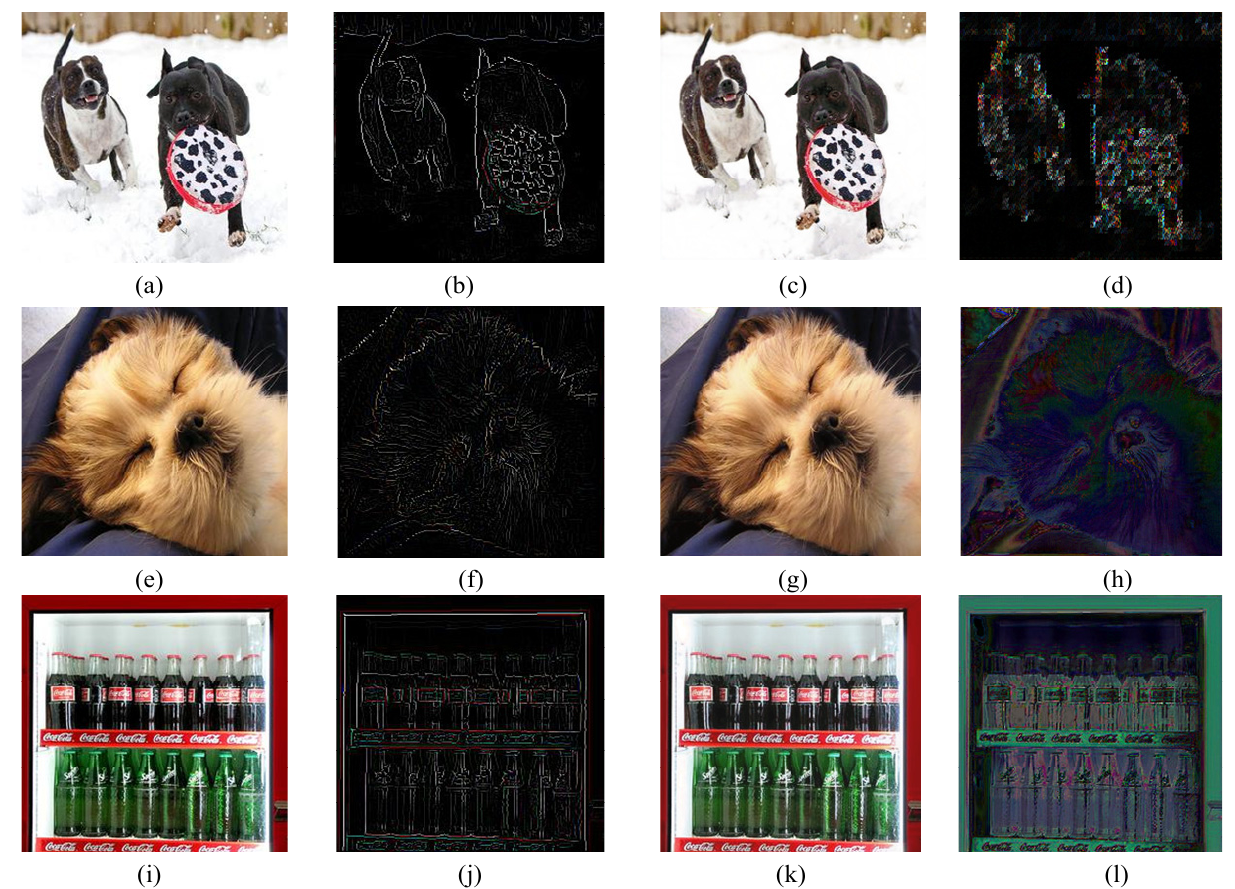
Figure 12. Difference images between the test image and the reconstructed one. ( a ), ( e ), and ( i ) are the original test images; ( b ), ( f ), and ( j ) are the multiscale interest points feature maps of ( a ), ( b ), and ( i ), respectively; ( c ), ( g ), and ( k ) are the reconstructed images of ( a ), ( e ), and ( i ), respectively; ( d ), ( h ), and ( l ) are the difference images of |( a )–( c )|, |( e )–( g )|, and |( i )–( k )|, respectively, when scale = 1.